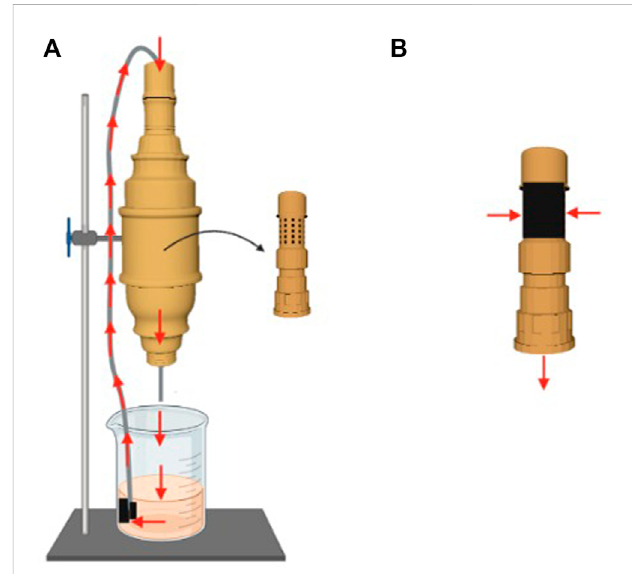
Schematic drawing of the fi ltering unit structure used in the experiments. (A) Illustration of the components and water fl ow; (B) Ag@ ACF-coated inner